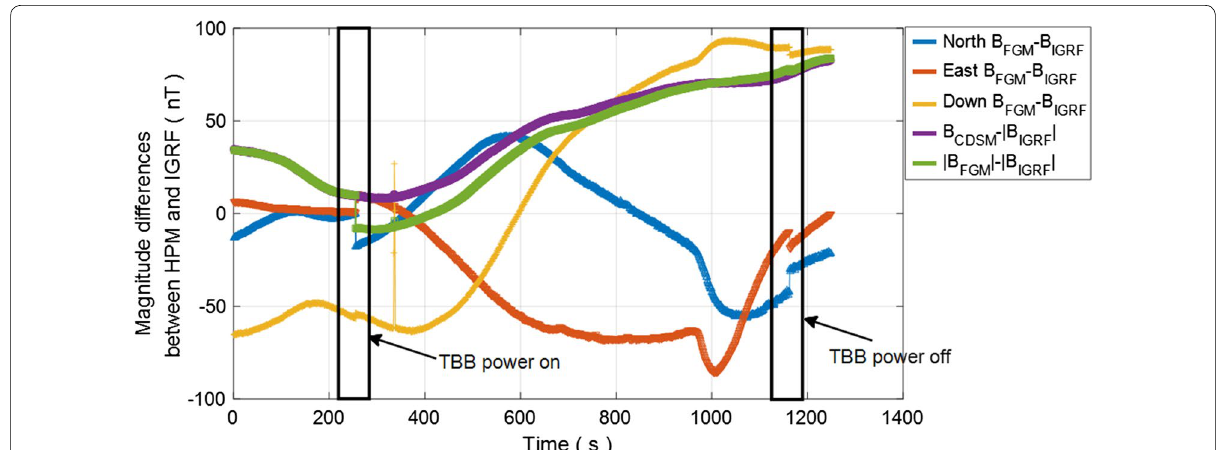
Fig. 16 Interferences caused by the TBB. When Tri-Band Beacon transmits signals to ground, the FGM measurements are disturbed